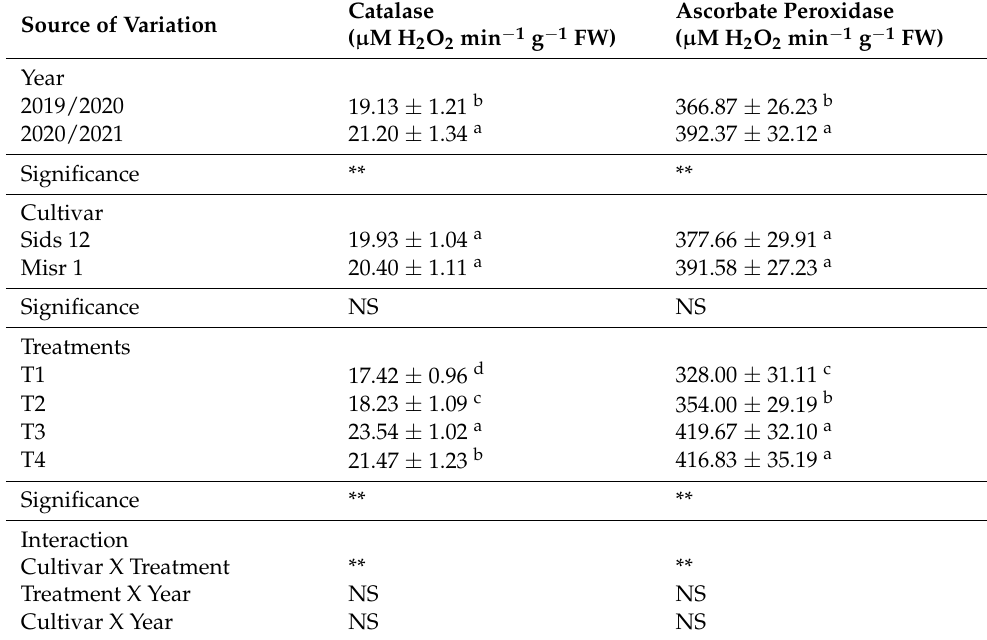
Table 3. Impact of different treatments (EM, CT, and combination) on antioxidant enzymes of wheat 70 days after sowing during the two growing